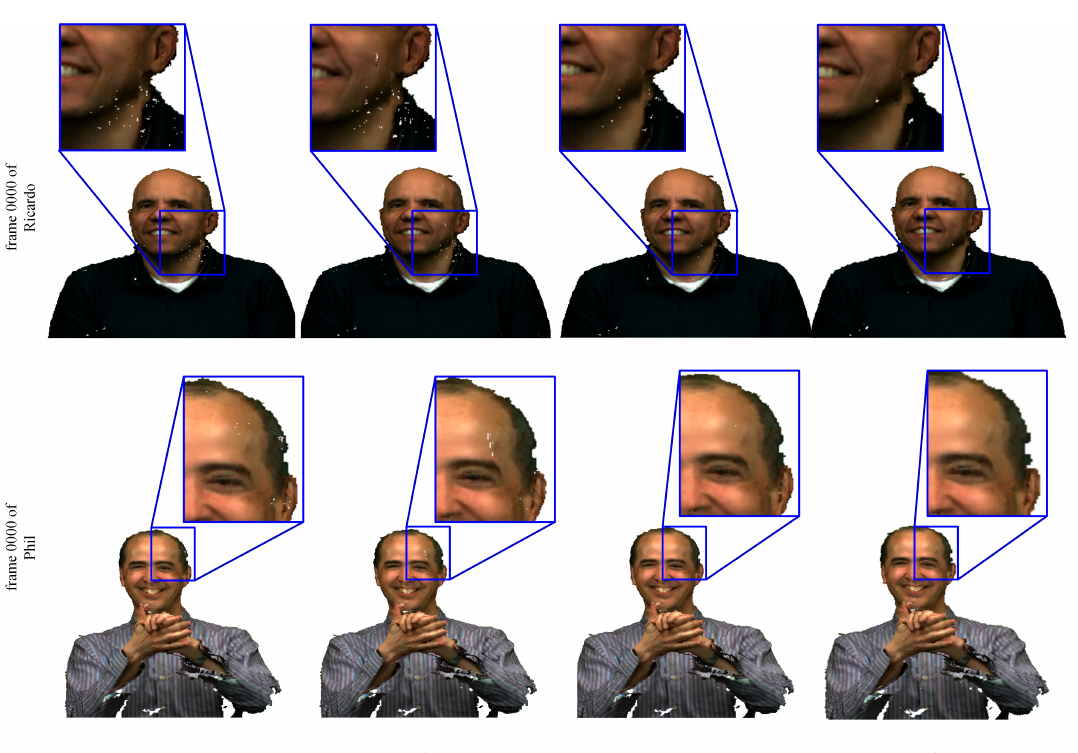
Figure 15. Results for subjective inspection in Microsoft Voxelized Upper Bodie’s dataset: ( a ) V-PCC with voxDim of 2; ( b ) V-PCC with voxDim of 4; ( c ) compressed by the curvature-grading-based refining method; ( d ) the original point clouds.